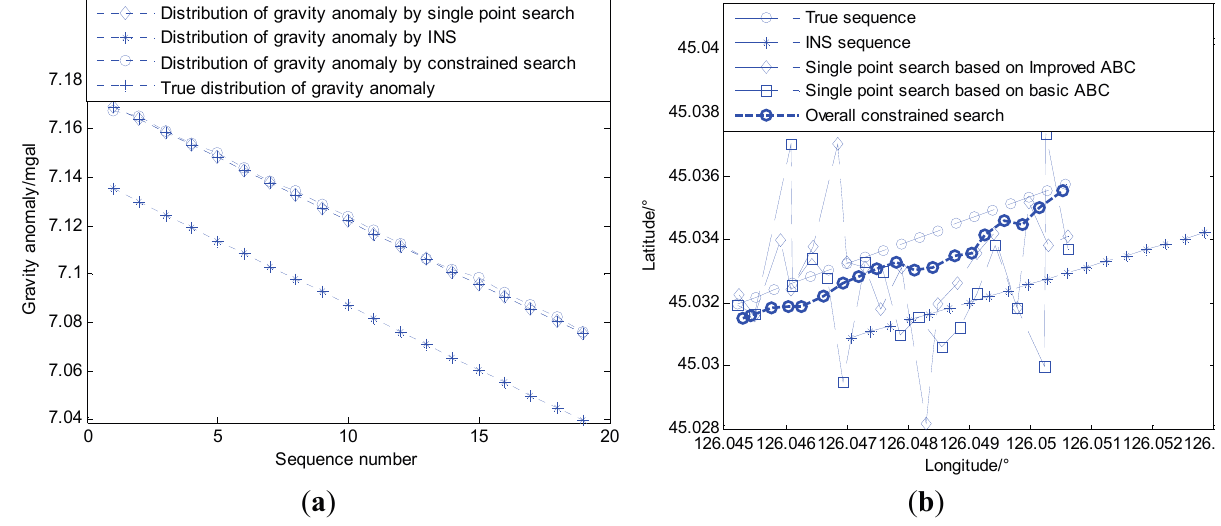
Figure 15. ( a ) Distributions of gravity anomaly; ( b ) Comparison of results for different search